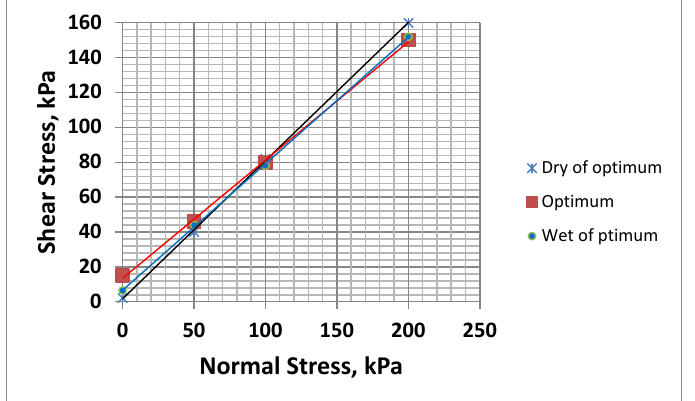
Figure 9. Normal stress vs. shear stress for mixture with compacted 5% bentonite with three differ ‐ ent moisture conditions .